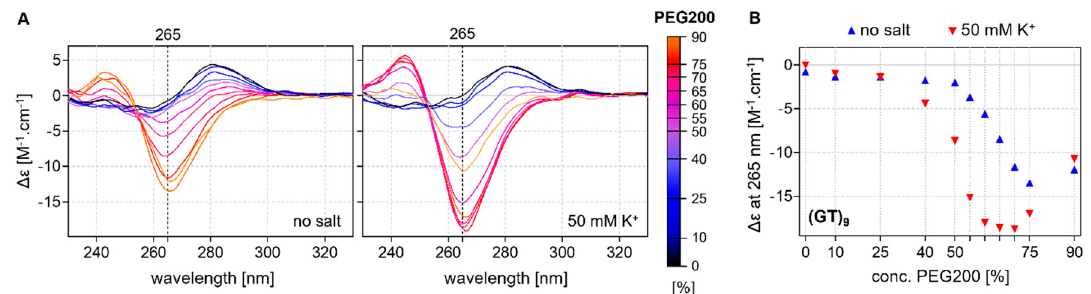
Figure 3. ( A ) CD profiles of (GT) 9 in the presence and absence of potassium obtained at various con- centrations of PEG200; ( B ) Dependence of the negative peak at 265 nm on PEG200 concentration; blue and red triangles represent the values obtained in the absence and presence of 50 mM KCl, respec- tively.